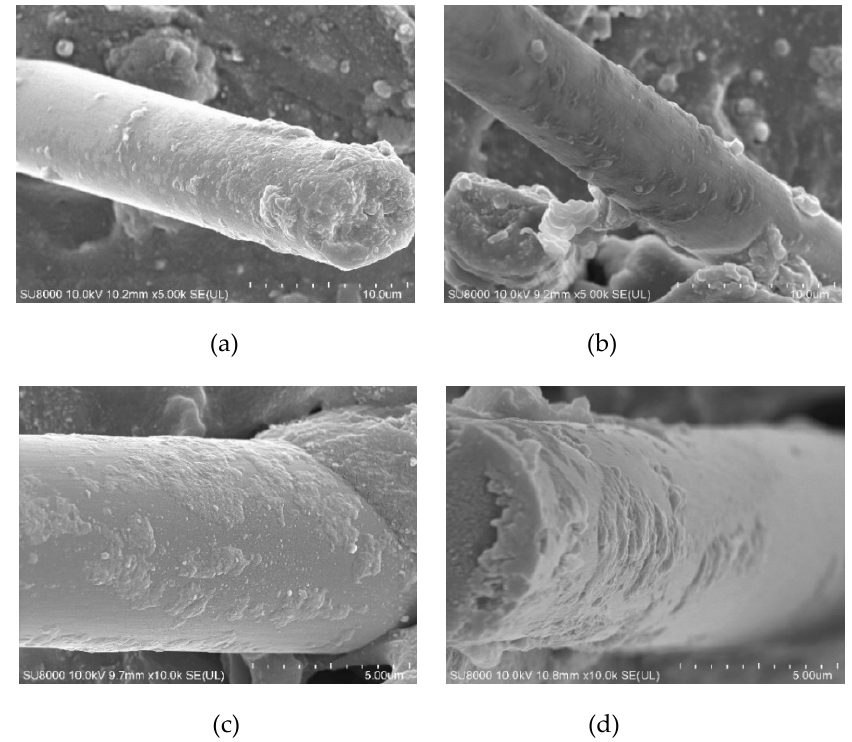
Figure 6. SEM picture of composites of CF modified by different processing times of dopamine. ( a ) The processing time of dopamine was 2 h; ( b ) the processing time of dopamine was 4 h; ( c ) the processing time of dopamine was 6 h; ( d ) the processing time of dopamine was 8 h;